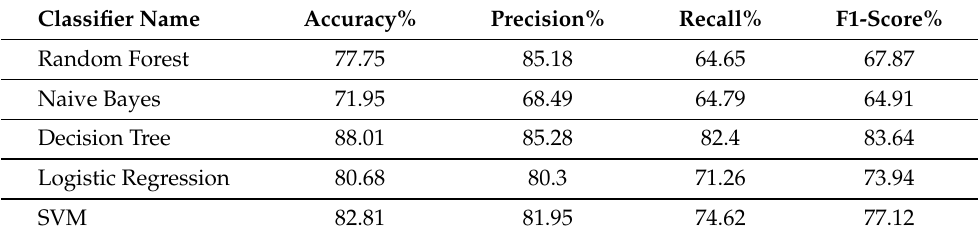
Figure 10. Confusion matrix for Moderna Dataset ( a ) using Random Forest ( b ) Naive Bayes ( c ) Deci- sion Tree ( d ) Logistic Regression ( e ) SVM. Table 7. Machine learning performance on Moderna